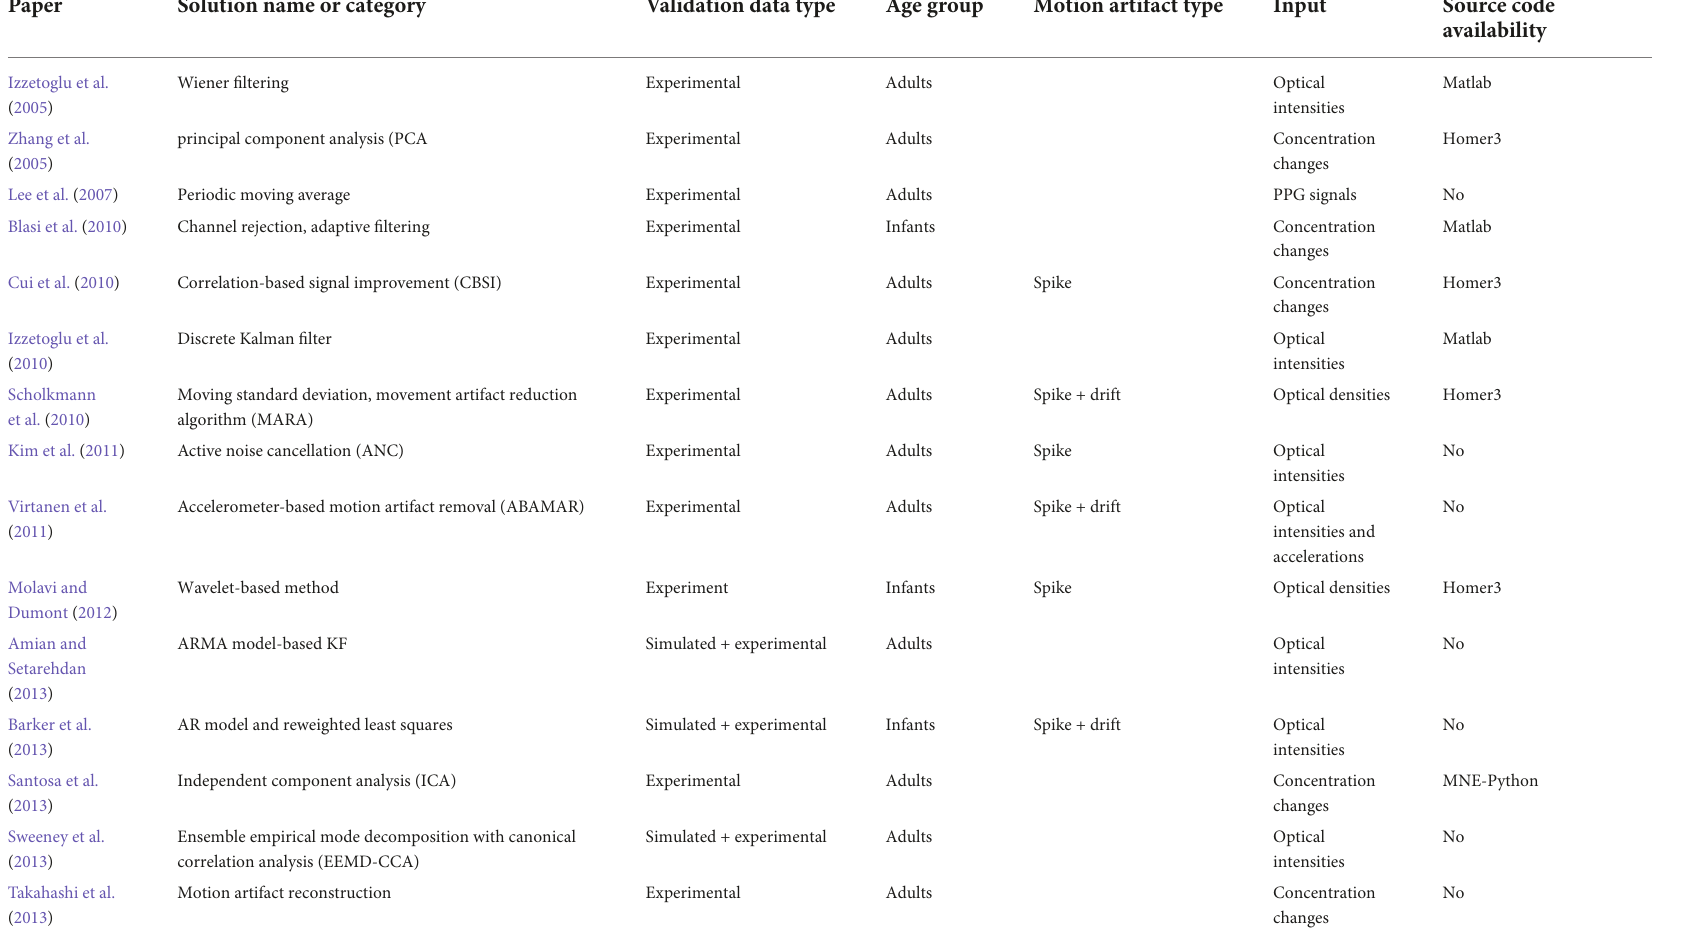
TABLE 5 List of motion artifact (MA) removal approaches and their